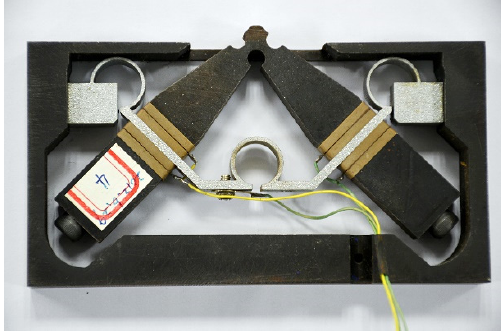
Figure 2. V-type linear ultrasonic motor.